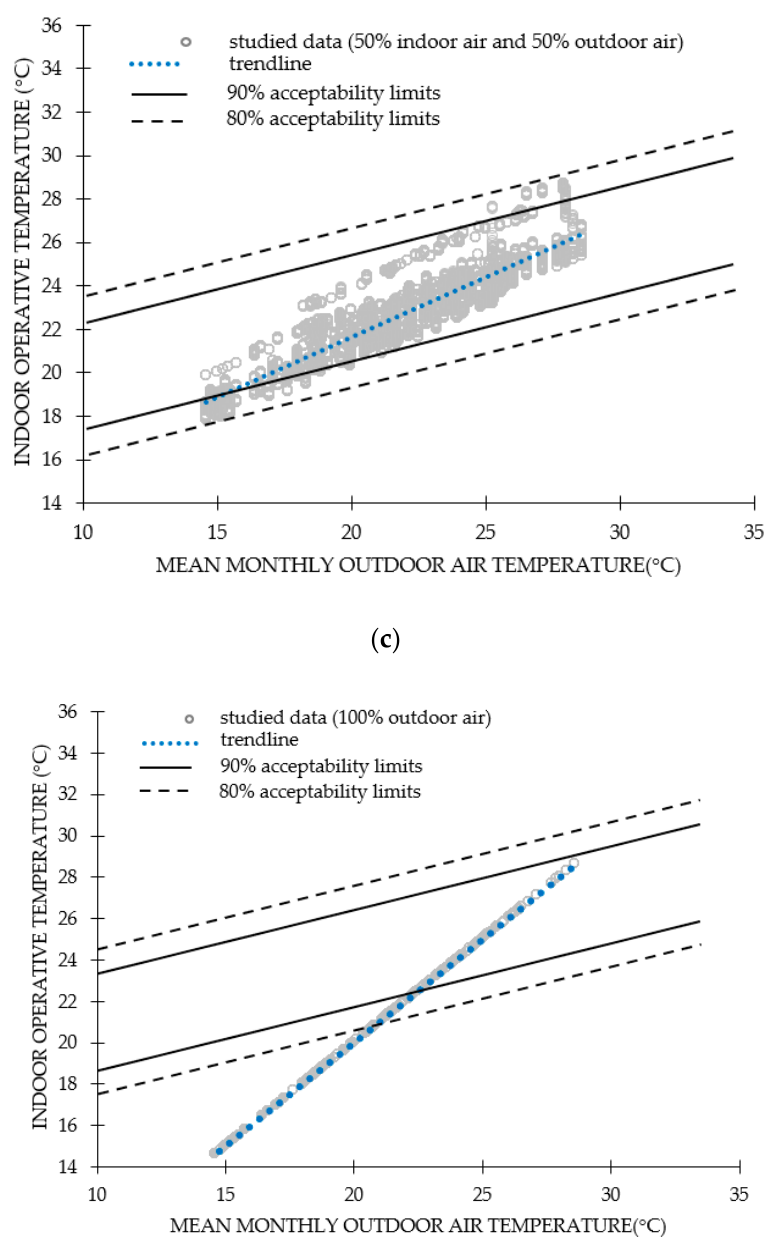
Figure 8. Mixed-mode ventilation in four cases of using: ( a ) 100% indoor air, ( b ) 70% indoor air and